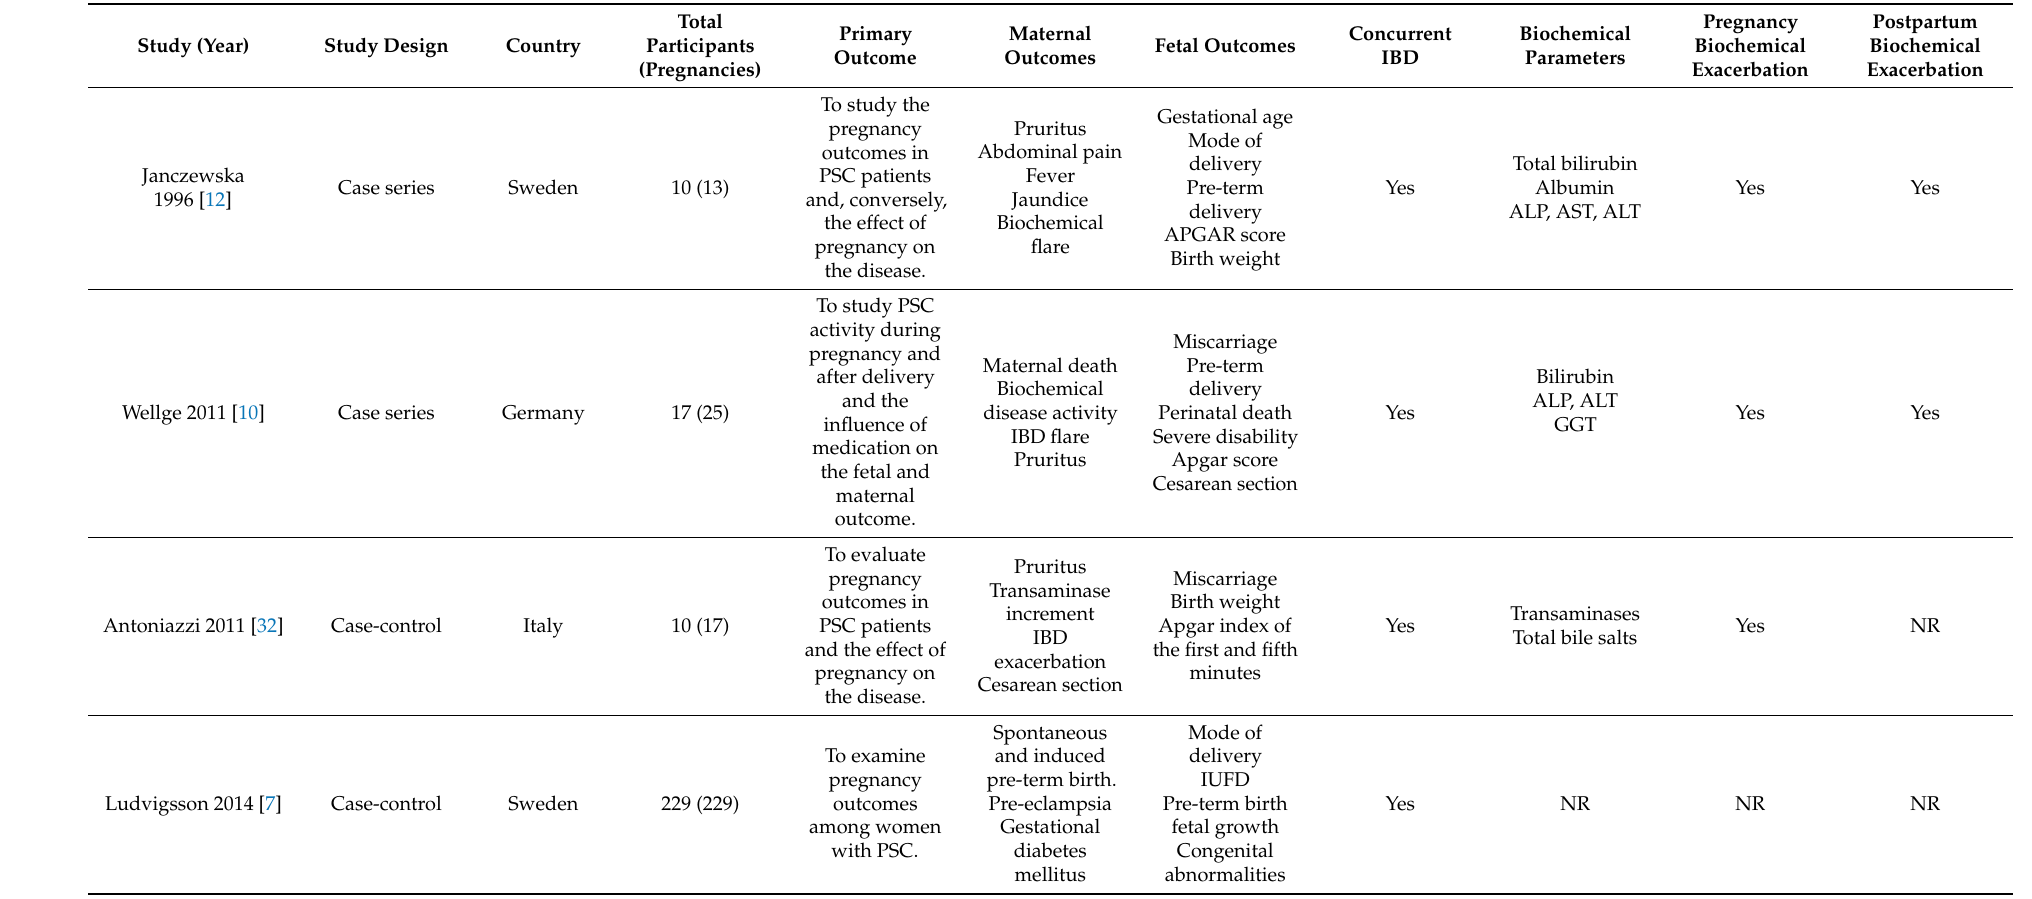
Table 2. Individual study characteristics for primary sclerosing cholangitis